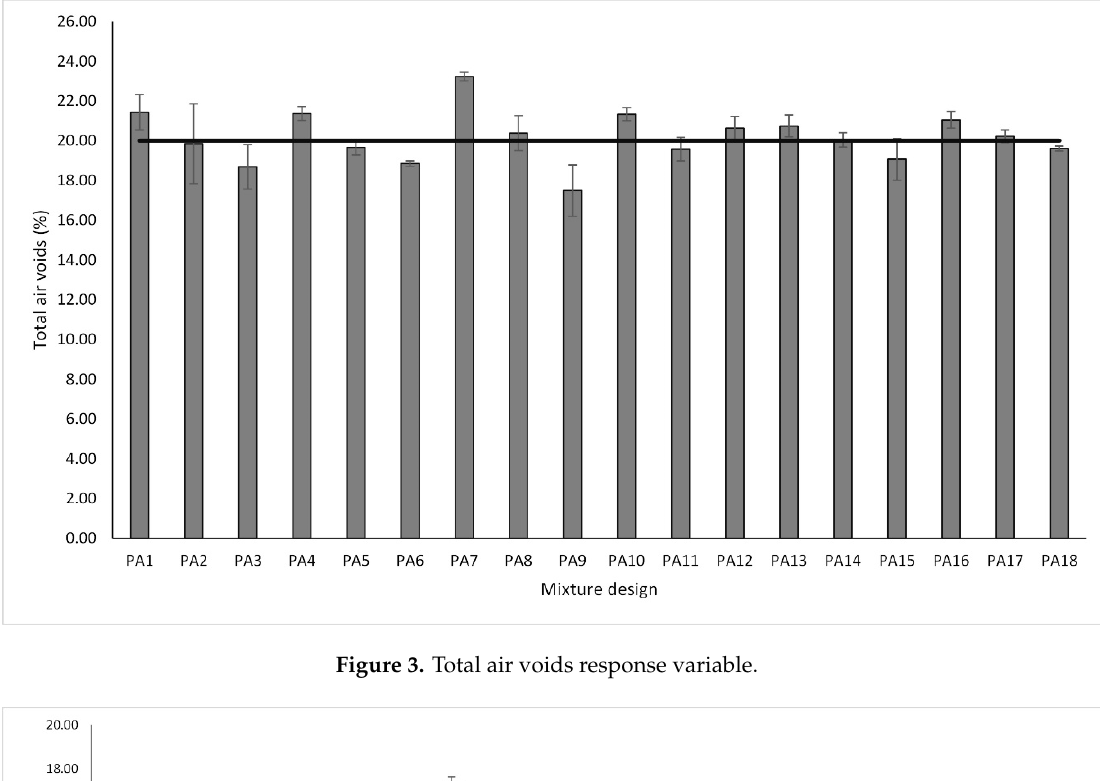
Figure 5. Linear relationship between total and interconnected air voids content. As higher values of (cid:1846) (cid:3002)(cid:3023) are relevant for functional quality improvement, the larger-the-better equation was used for the calculation of the SN ratios and analyzing the impact of the different control factors. In line with the Taguchi methodology, the best parameter for each control factor is the one that has the highest SN ratio value. Consequently, the parameters and SN ratios for the control factors giving the best (cid:1846) (cid:3002)(cid:3023) are shown in graph form in Figure 6. According to the results, the levels with their respective SN ratio for each control factor for the best (cid:1846) (cid:3002)(cid:3023) were identified for FC factor (level 1, SN ratio = 26.39), BC factor (level 1, SN ratio = 26.65), and for FT factor (level 1, SN ratio = 26.21). It means that the optimal solution values for total porosity can be obtained with a binder content of 4.50%, without fibers and pure limestone as a type of filler. Likewise, BC is the factor that most affects this property followed by fiber content, while the filler type is the least notable factor.